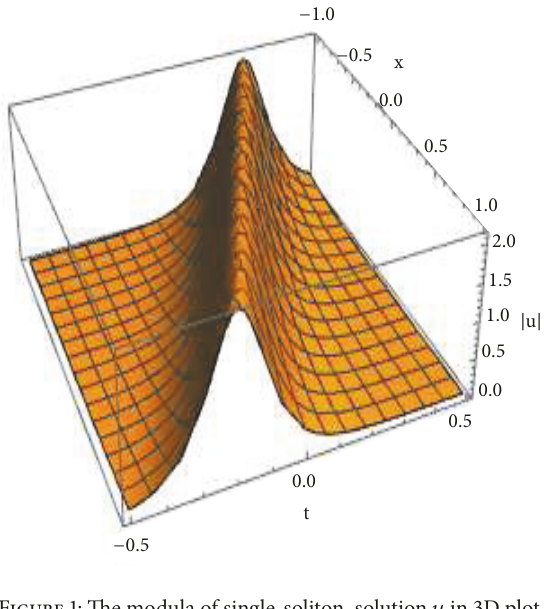
Figure 1: The modula of single-soliton, solution 푢 in 3D plot.